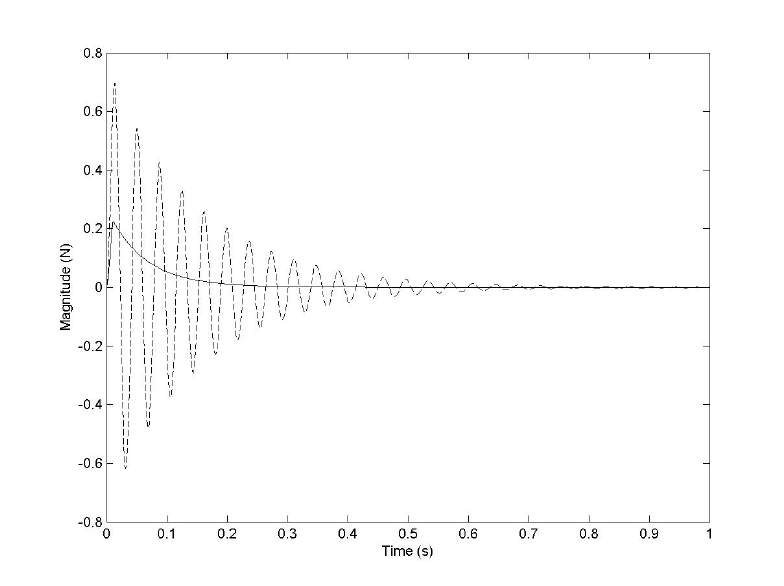
Fig. 20. Transmitted force variations of the system using the PID controller subjected to impulse engine disturbance. Open loop (–) and PID controlled (solid).